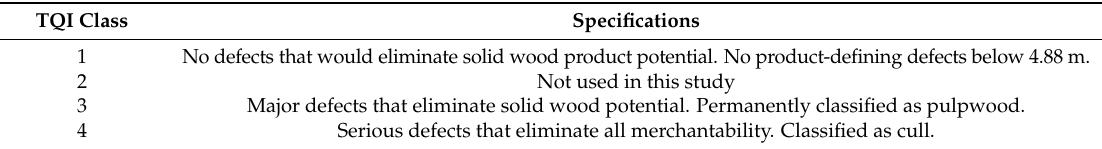
Table 4. Tree quality index (TQI), specifications utilized for grading standing trees in the PMRC SAGS Culture × Density